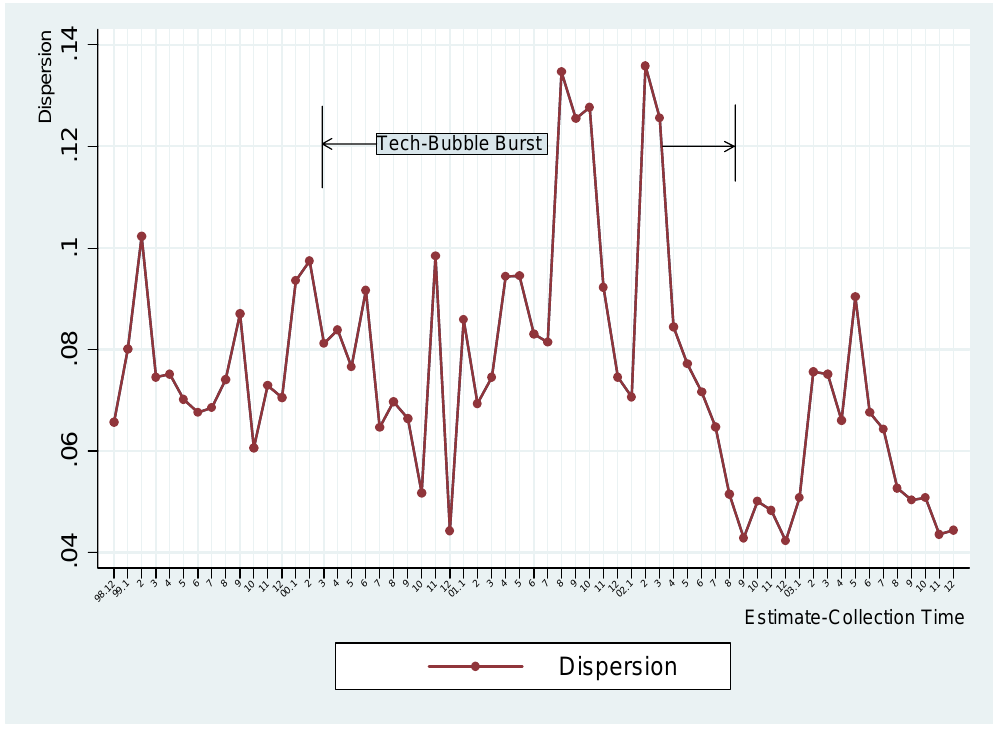
Figure 6: Monthly Average AFD (1998.12 -